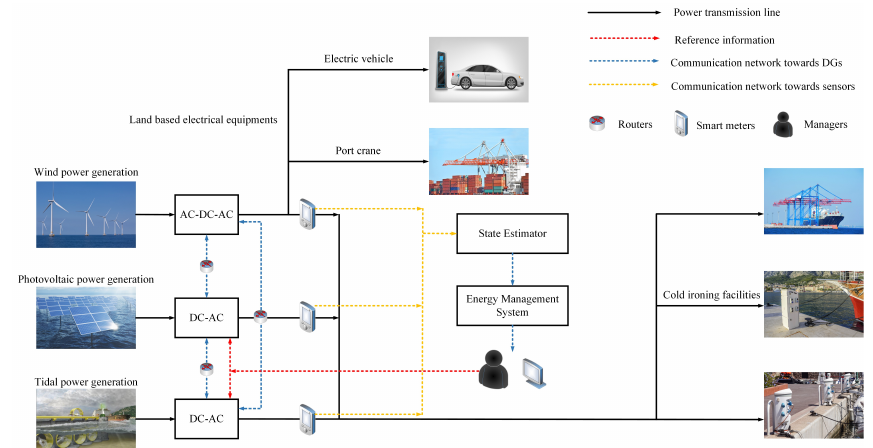
Figure 1. The typical structure of a seaport